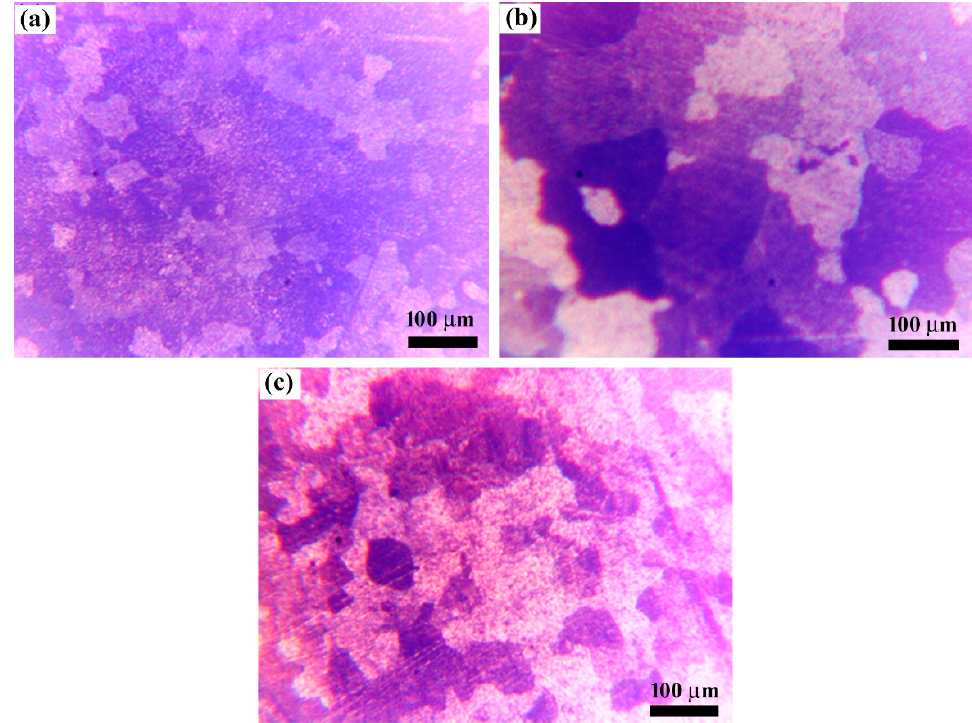
Figure 8. Optical microstructures of ( a ) SP1, ( b ) SP2 and ( c ) SP3 .